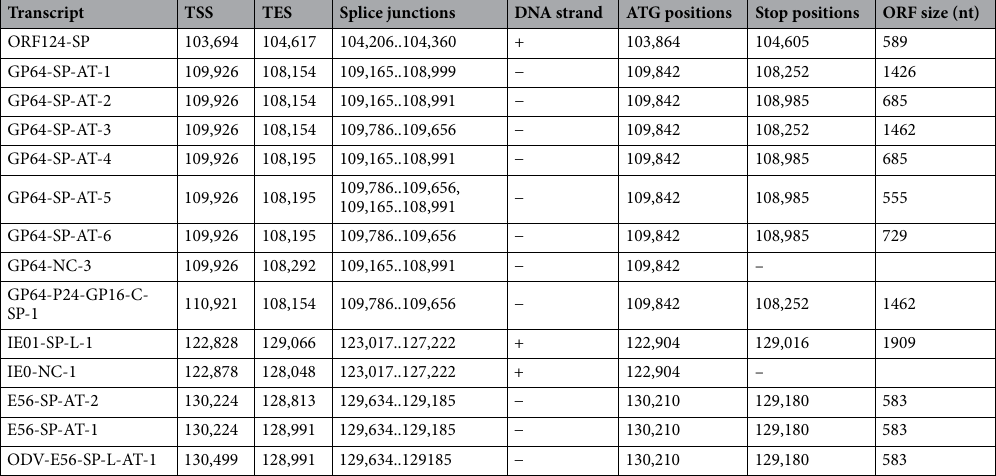
Table 3. TSS, TES, splice junction, ATG and stop codon positions of the spliced AcMNPV